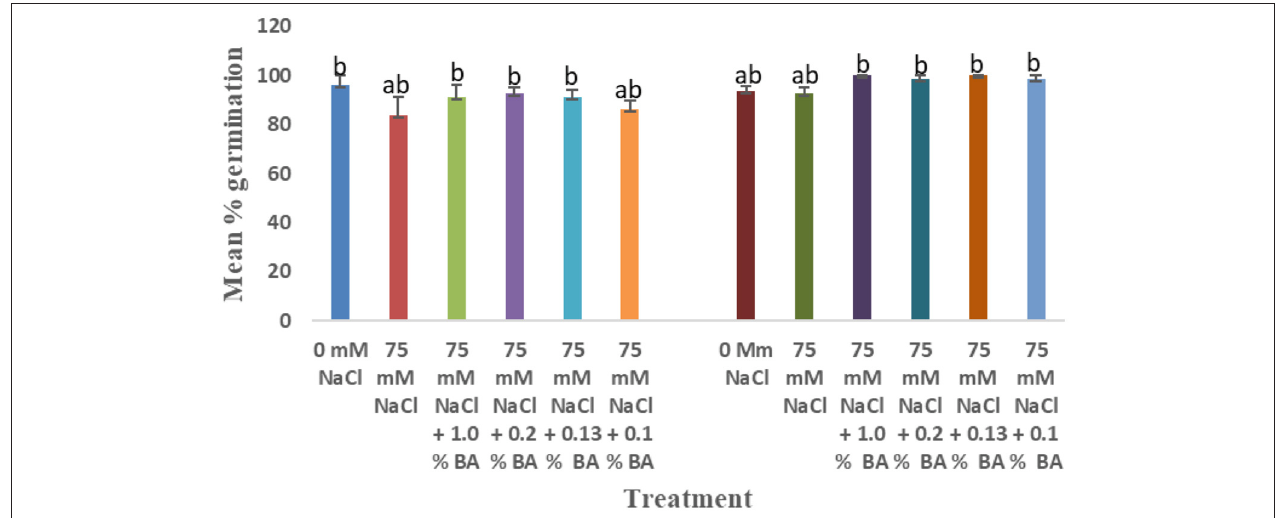
FIGURE 6 | Effect of BA cell-free supernatant on mean percentage germination of corn and soybean exposed to 75mM NaCl for 72h. Treatments with similar letters are not significantly different. Treatments with different letters are significantly different.